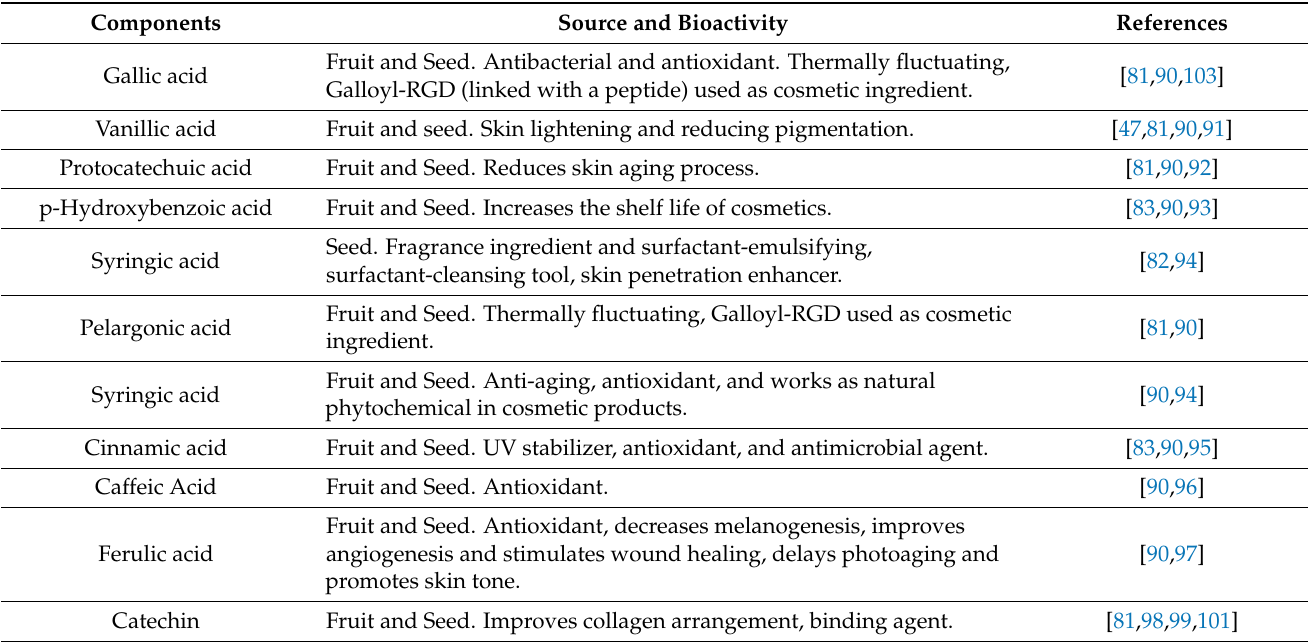
Table 4. List of phenolic acids derived from date fruit and seed and their cosmetic applications. Components Source and